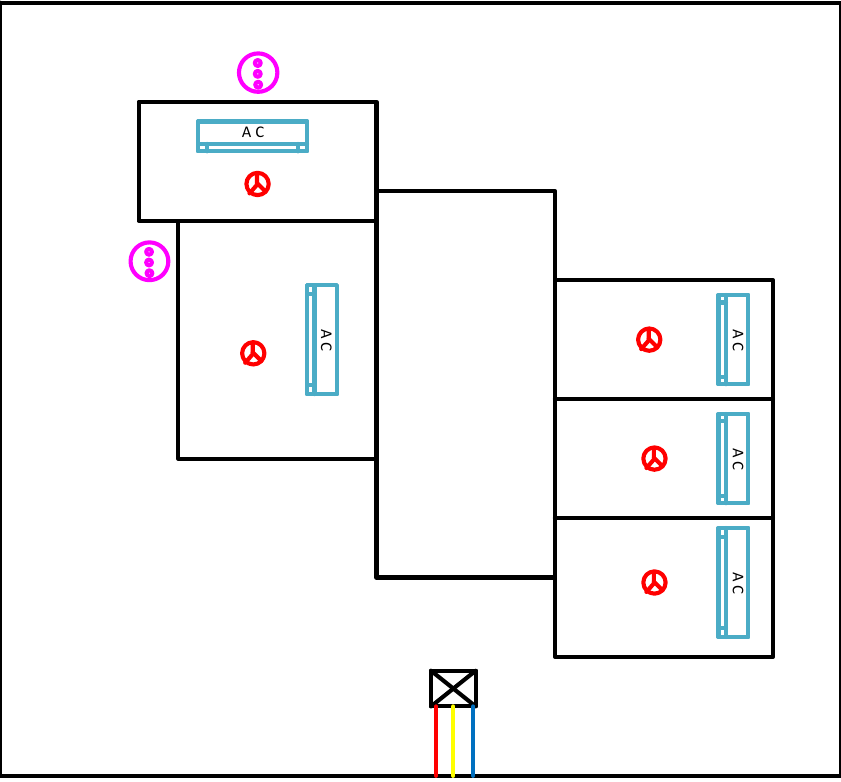
Figure 7. Sketch of the coordinator